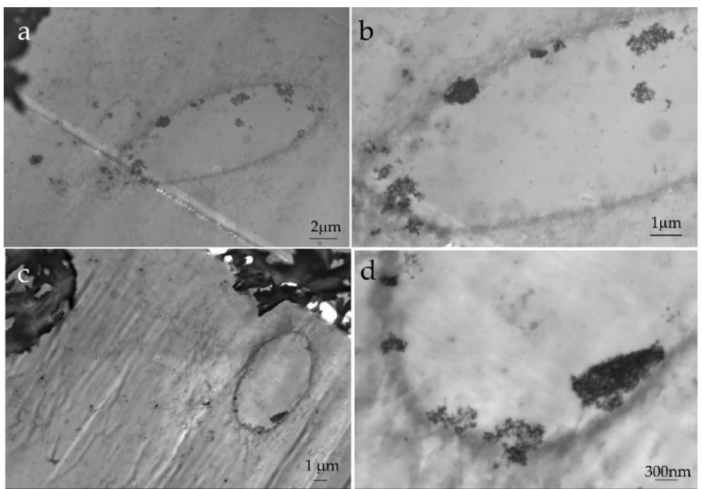
Figure 4. ( a , c ) Scanning electron microscopy images in transmission mode (TSEM) of two areas of an interstices between PC fibers inside the epoxy matrix after ultramicrotome sample preparation. Outside the elliptical boundaries of the interstice, the rough structures of partially dissolved PC can be seen (as shown in Figure 3b). ( b , d ) Zoomed-in images show the BNP domains at the boundaries between the PC fiber and the epoxy occupying the